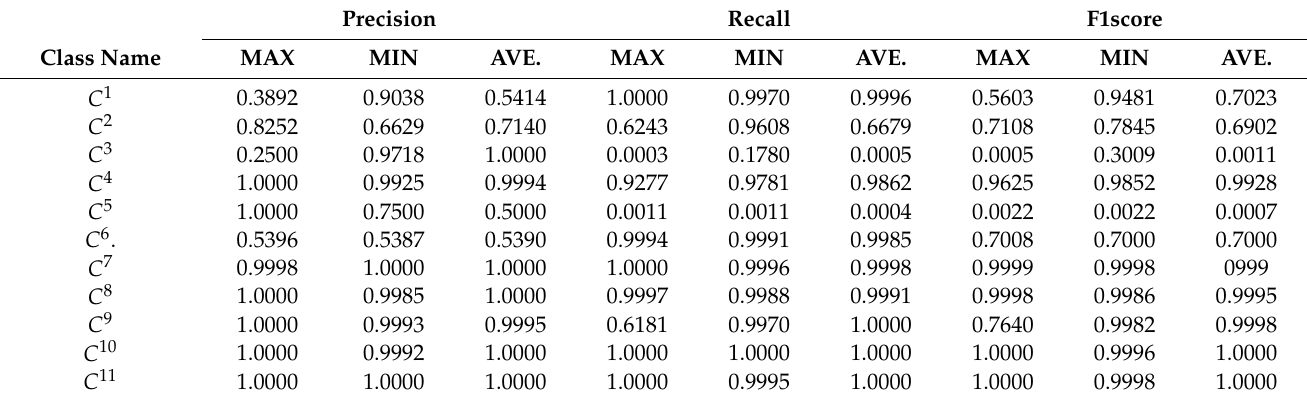
Table 15. Performance analysis for N-BaIoT with SVM and MI feature selection on the test dataset.